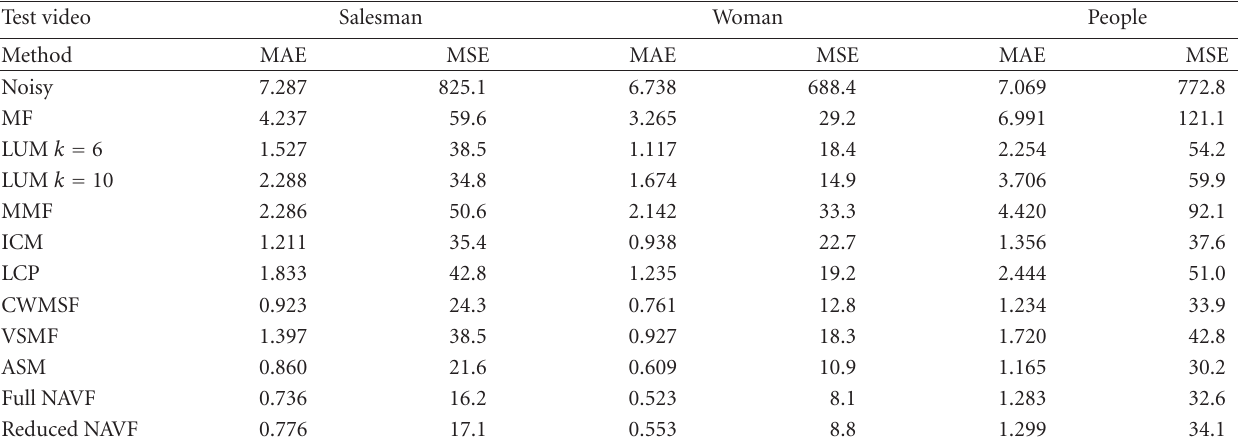
Table 2: Comparison of the presented algorithms using test videos corrupted with 10% impulsive